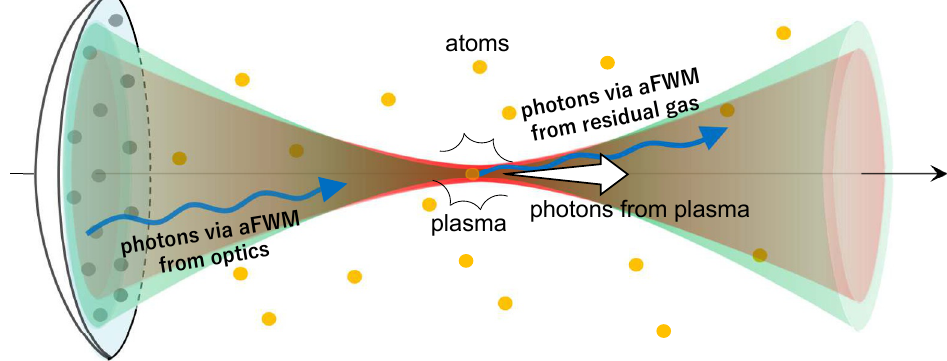
Figure 2 . Possible background sources originating from atoms and plasma in the quasi-parallel collision system. The atomic four-wave mixing (aFWM) photons can be produced from residual gas and optical elements, with the same wavelength as the signal photons. Plasma can be generated by focusing high-intensity laser fields at the focal point and ionizing the residual gas around